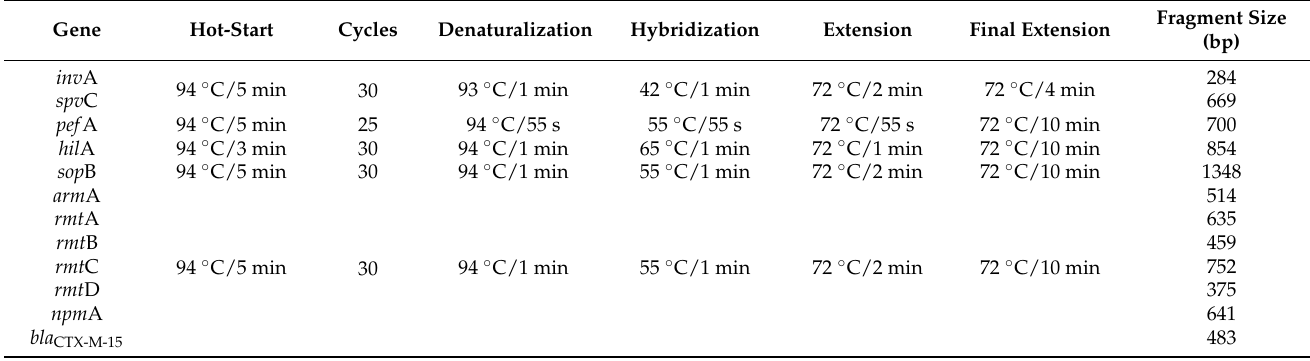
Table 2. Thermal profiles set for each genetic